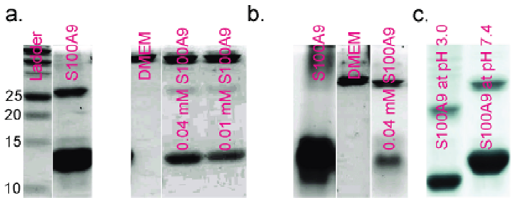
Figure 5. Electrophoresis of S100A9 incubated with NHSY5Y cells. (a) and (c) SDS PAGE; (b) Native PAGE. Panel (a) has the following designations: column 1 corresponds to the ladder; 2 to S100A9 (0.2 mM); 3 to cell culture buffer DMEM; 4 to S100A9 (0.04 mM) with cells in DMEM for 3 d; 5 to S100A9 (0.01 mM) with cells in DMEM. In panel (b), 1 to S100A9 (0.2 mM); 2 to DMEM; 3 to S100A9 (0.04 mM) with cells in DMEM for 3 d. (c) 0.2 mM S100A9 at pH 3.0 and 7.4. The data was obtained by several experiments, and integrated together according to the